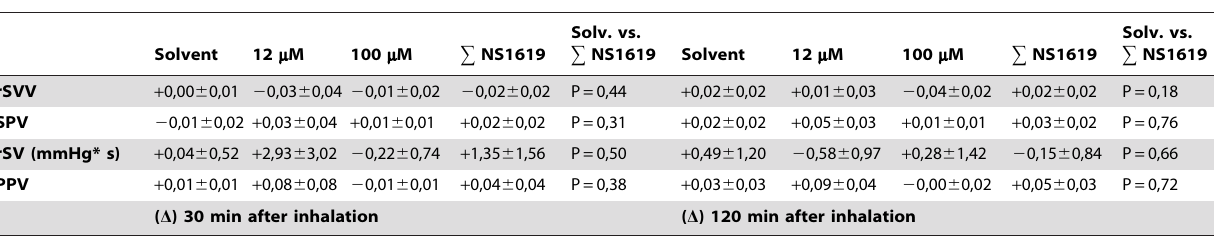
Table 3. Intravascular volume parameters.